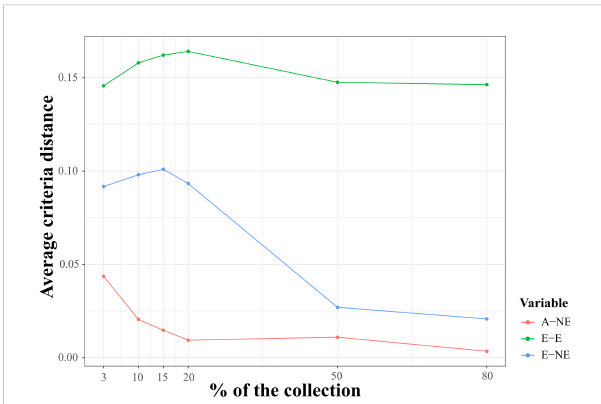
FIGURE 4 Qualitative evaluation of average Accession to Nearest Entry (A-NE) metrics used for diverse core collection identi fi cation and quality of core collections. The average criteria distance (y-axes) for three distance-based metrics A-NE, E-E (average Entry to Entry distance), and E-NE (average Entry to Neatest Entry distance) calculated using the core entries identi fi ed with A-NE criterion and single nucleotide (SNP) markers for six core collection sizes of 3, 10, 15, 20, 50, and 80 percent of whole samples genotyped in this study